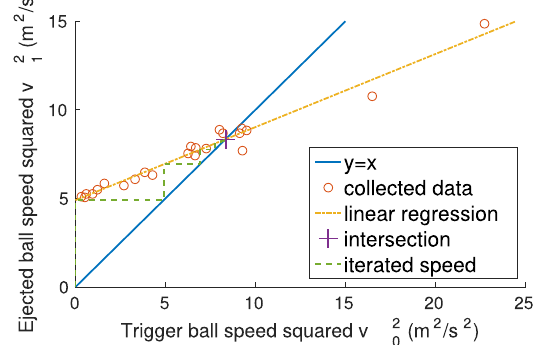
Fig. 7. Ejection velocity squared v 2 1 as a function of trigger velocity v 2 0 , for small balls and n =5. Each circle corresponds to one ejected ball. The linear relation is a general feature, regardless of choice of ball size and n . Chained cannon : When the cannons are coupled together, the speed squared follows a convergent series, represented by the green dashed line. With a large number of cannons, the fi nal speed corresponds to the purple intersection cross.